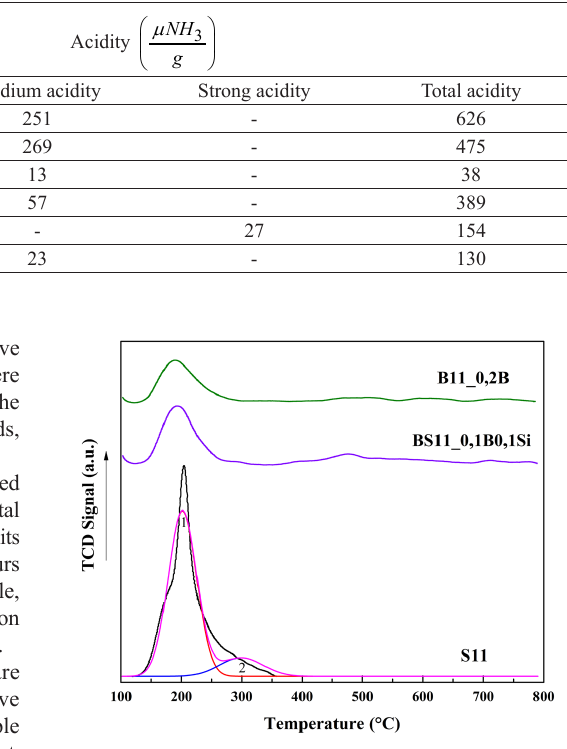
Figure 10. TPD-NH